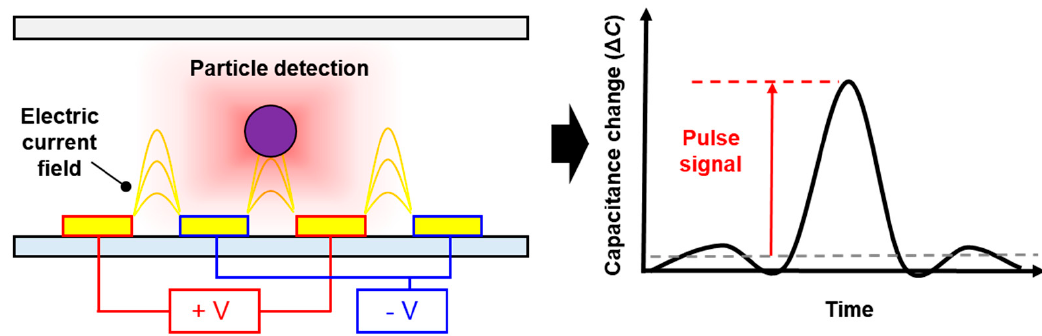
Figure 1. Simplified schematic diagram for particle detection under applied AC voltage. Impedance ( Z) is defined as the ratio of two electrical characteristics, one of which system (i.e., electric current response ( I )), and the other is the frequency-dependent exci- tation signal with a small voltage (AC voltage ( V) ) [33].